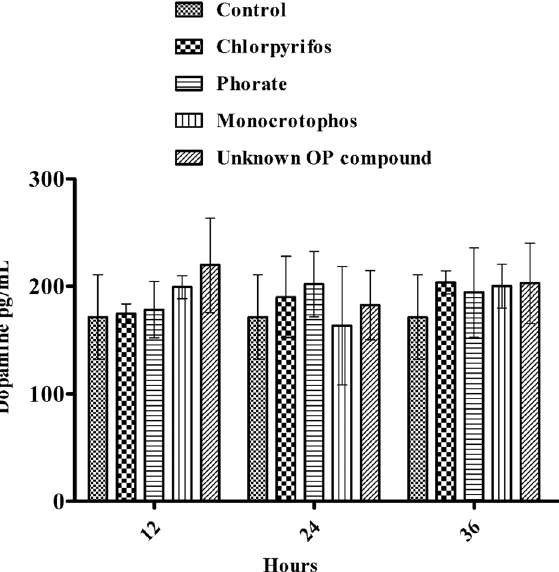
Figure 2. Neurotransmitter levels (dopamine levels) after acute OP poisoning with chlorpyrifos, phorate, monocrotophos, and unknown OP compounds; dopamine concentrations in human plasma samples from 12 to 36 h on consecutive days after admission to the hospital for acute OP poisoning; neurotransmitter levels were quantified using ELISA kits. The outcomes are presented as the mean ± SD (OP poisoning cases (N = 3) and control group non-OP exposures(N = 5)). p > 0.05was considered nonsignificant.